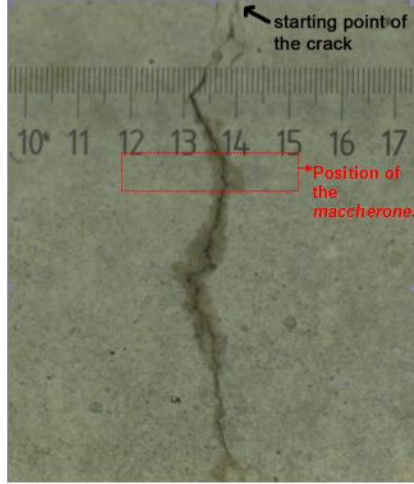
Figure 16. Side view of the specimen with the maccherone after the pre-loading stage. The arrow indicates the point of the crack opening; the rectangle indicates approximately the crack path is clearly visible.